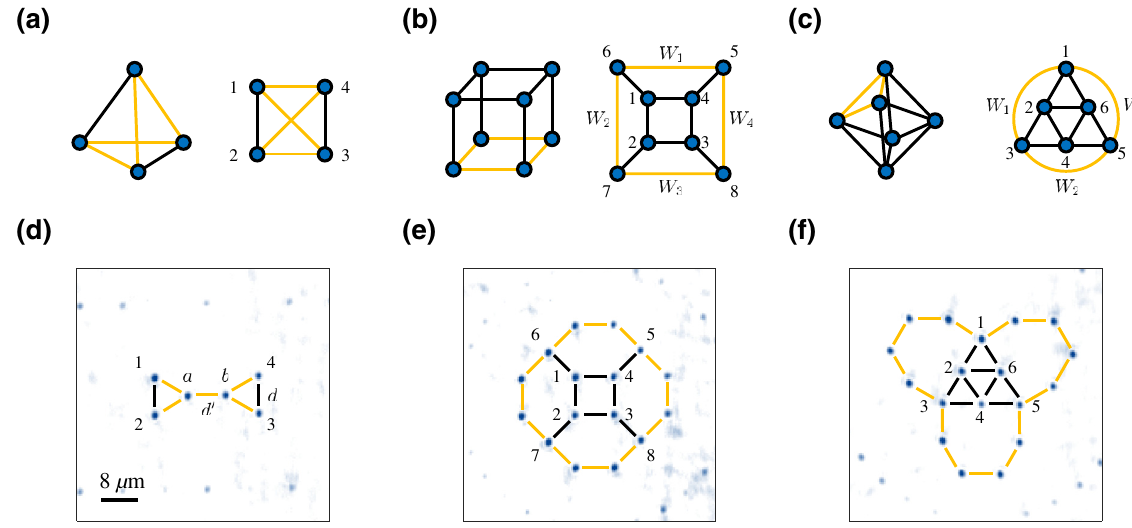
FIG. 1. The Platonic graphs and their two-dimensional (2D) arrangements. (a)–(c) The tetrahedral graph K 4 (a), the cube graph Q 3 (b), and the octahedron graph K 2,2,2 (c), in which the yellow edges are to be replaced by quantum wires. (d) The quantum-wired , uses one quantum wire, W , of two wire atoms, to replace the four yellow edges of K 4 , so there are six atoms and tetrahedral graph, K (cid:6) 4 seven equal-length edges in K (cid:6) . (e) The quantum-wired cube graph, Q (cid:6) uses four quantum wires, W 1,2,3,4 , each made up of two wire 4 3 . (f) The quantum-wired octahedron graph, atoms, to replace the four yellow edges of Q 3 , so there are 16 atoms and 20 edges in Q (cid:6) 3 uses three quantum wires, W 1,2,3 , each made up of four wire atoms, to replace the three yellow edges of K 2,2,2 , so there are 18 K (cid:6) 2,2,2 atoms and 24 edges in K (cid:6) . The lengths are d (cid:6) for the edges involved with quantum wires and d for all other 2,2,2